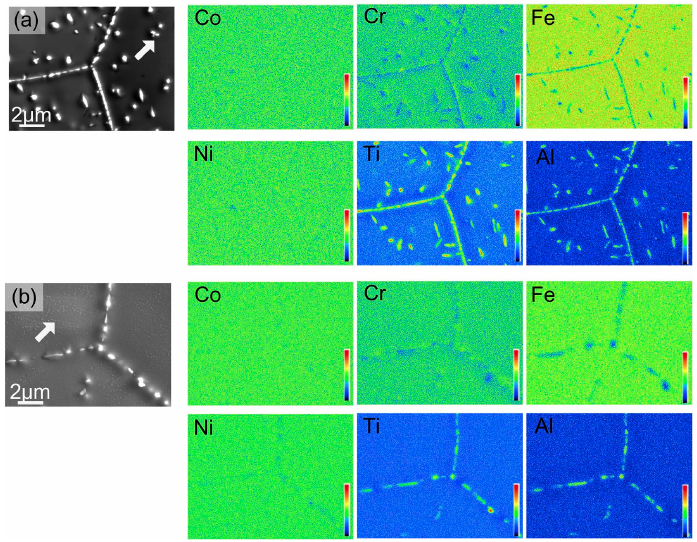
Figure 9. Elemental mapping of (Co 35 Cr 25 Fe 40- x Ni x ) 94 Ti 3 Al 3 with x = 5 ( a ) and (Co 35 Cr 25 Fe 40- x Ni x ) 94 Ti 3 Al 3 with x = 14 ( b ) alloy after aging at 800 °C for 16 h. Reprinted with permission from Ref. [66]. Copyright 2019 Elsevier.